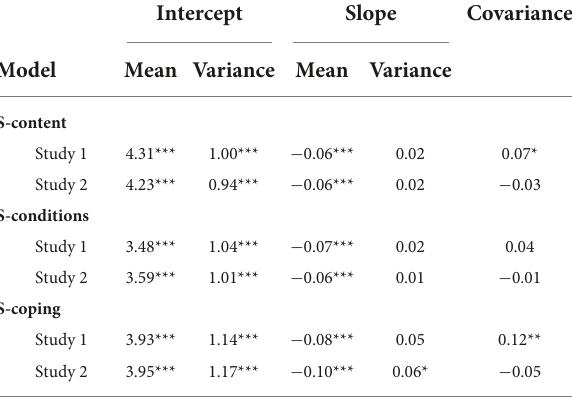
TABLE 3 Unstandardized parameter estimates for the unconditional LGCMs in study 1 and study 2.